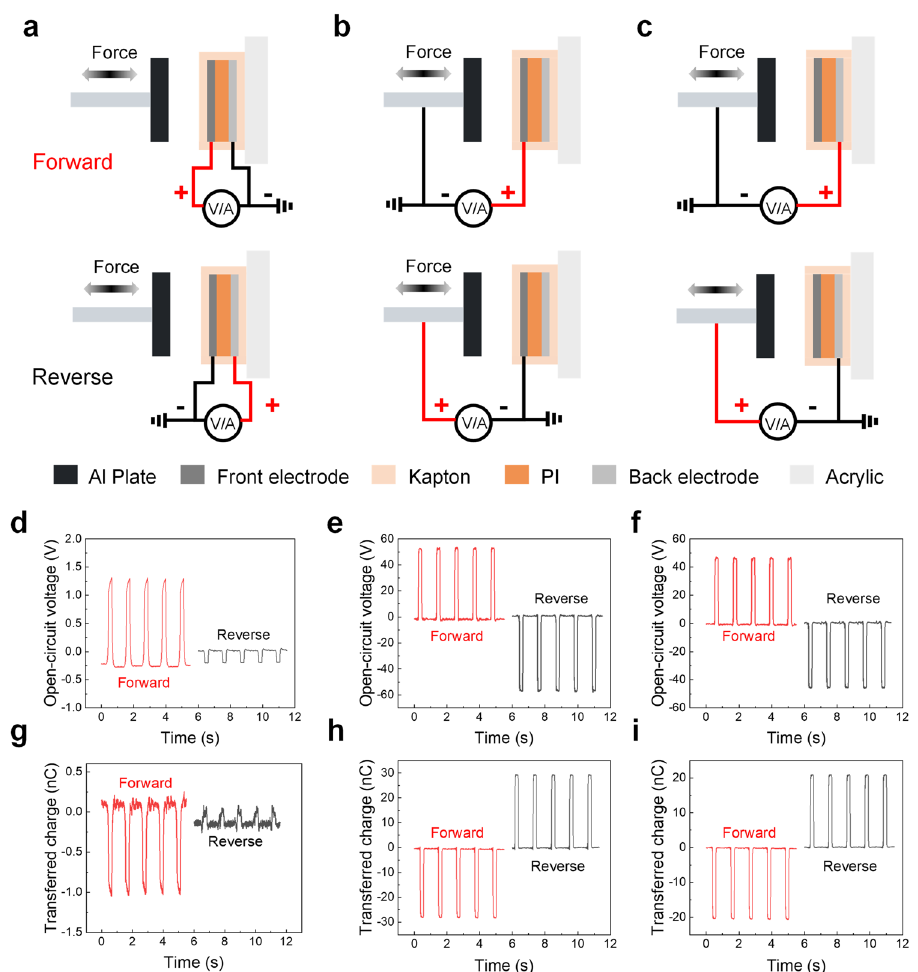
Fig. 2 Verifying the existence of SE-TENG in a compression test. a Schematic diagrams of the forward connection and reverse connection when measuring the electric signals between the front electrode and the back electrode of the PI-based device. The corresponding open-circuit voltage and transferred charge results are shown in d and g , respectively. b Schematic diagrams of the forward connection and reverse connection when measuring the electric signals between the front electrode and the Al plate. The corresponding open-circuit voltage and transferred charge results are shown in e and h , respectively. c Schematic diagrams of the forward connection and reverse connection when measuring the electric signals between the back electrode and the Al plate. The corresponding open-circuit voltage and transferred charge results are shown in f and i ,